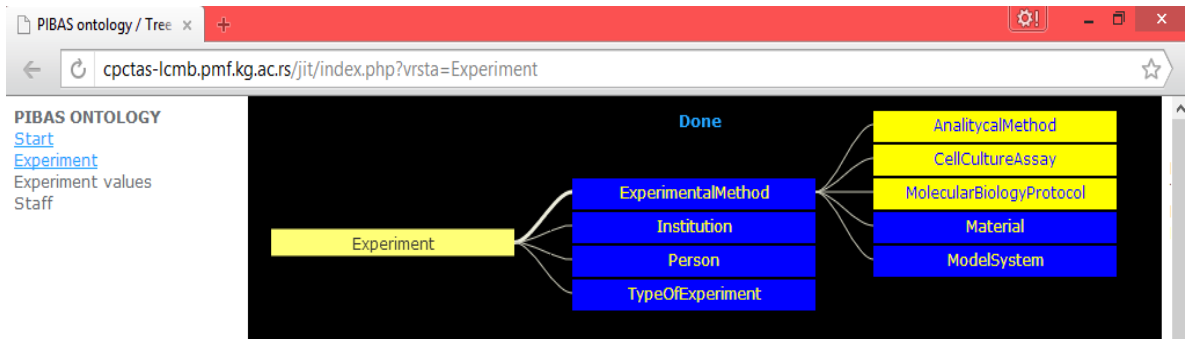
Figure 4. Graphical presentation of Experiment hierarchical structure on web page. Ontology supported knowledge